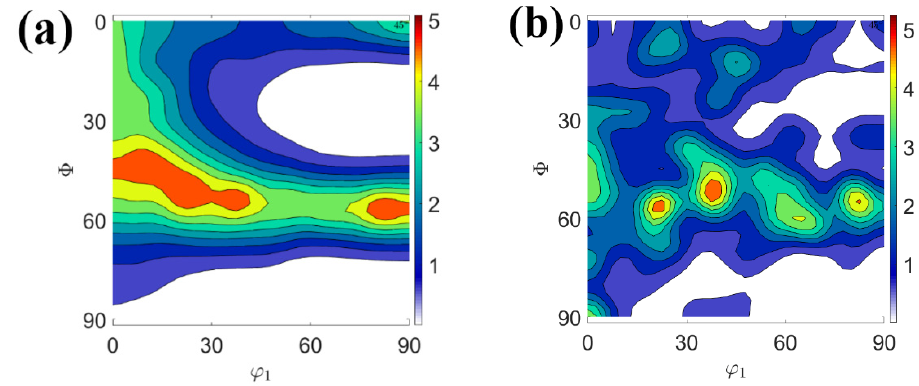
Figure 4. The ODFs of the rolled sample ( a ) and fully recrystallized sample ( b ).